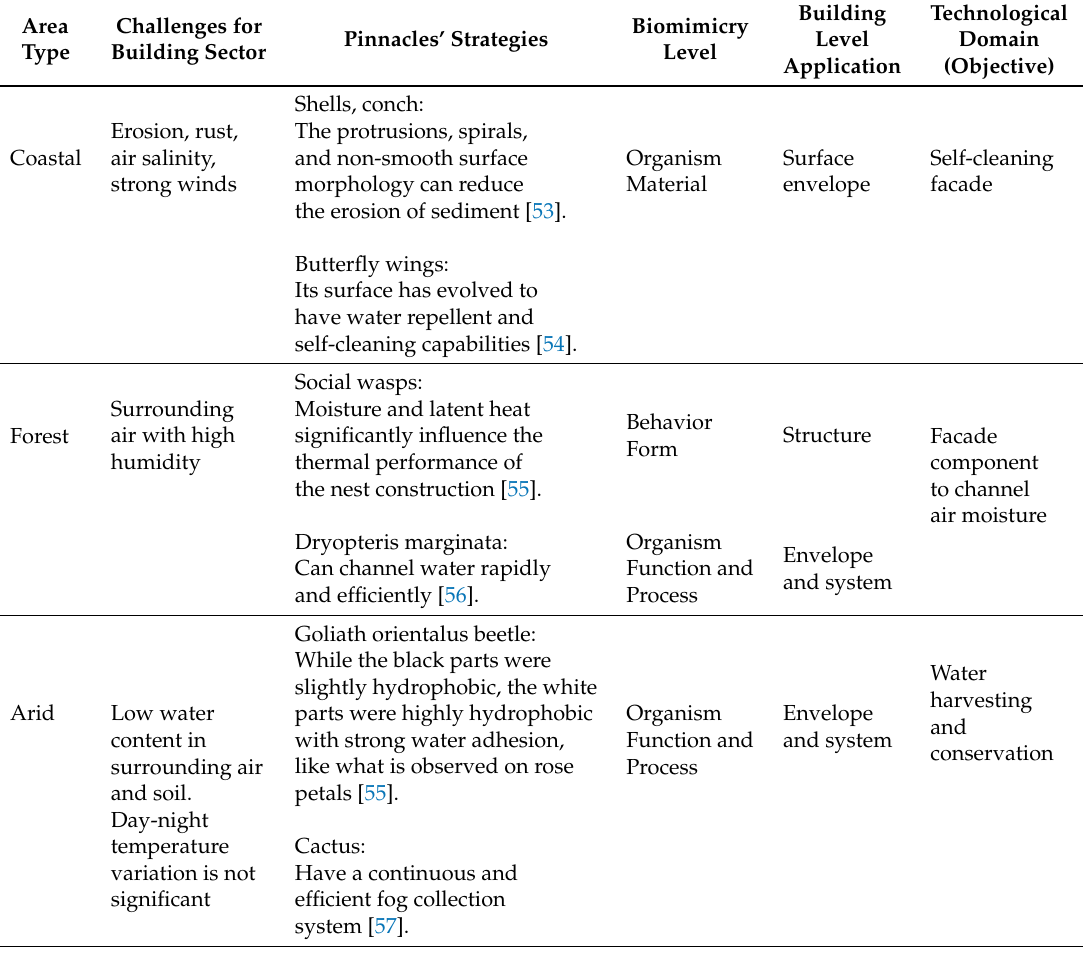
Table 2. Summary of identified pinnacles and biomimicry-level-based strategies for given building